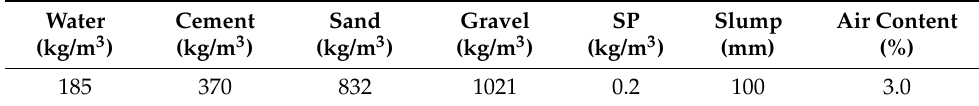
Table 1. Mix proportions and fresh properties of